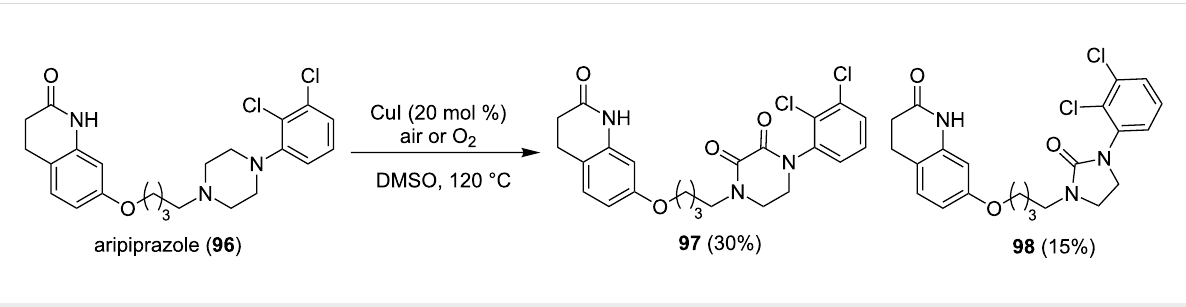
Figure 16: Copper-catalyzed aerobic C–H oxidation of piperazines by Touré, Sames, et al. in 2013 [67].